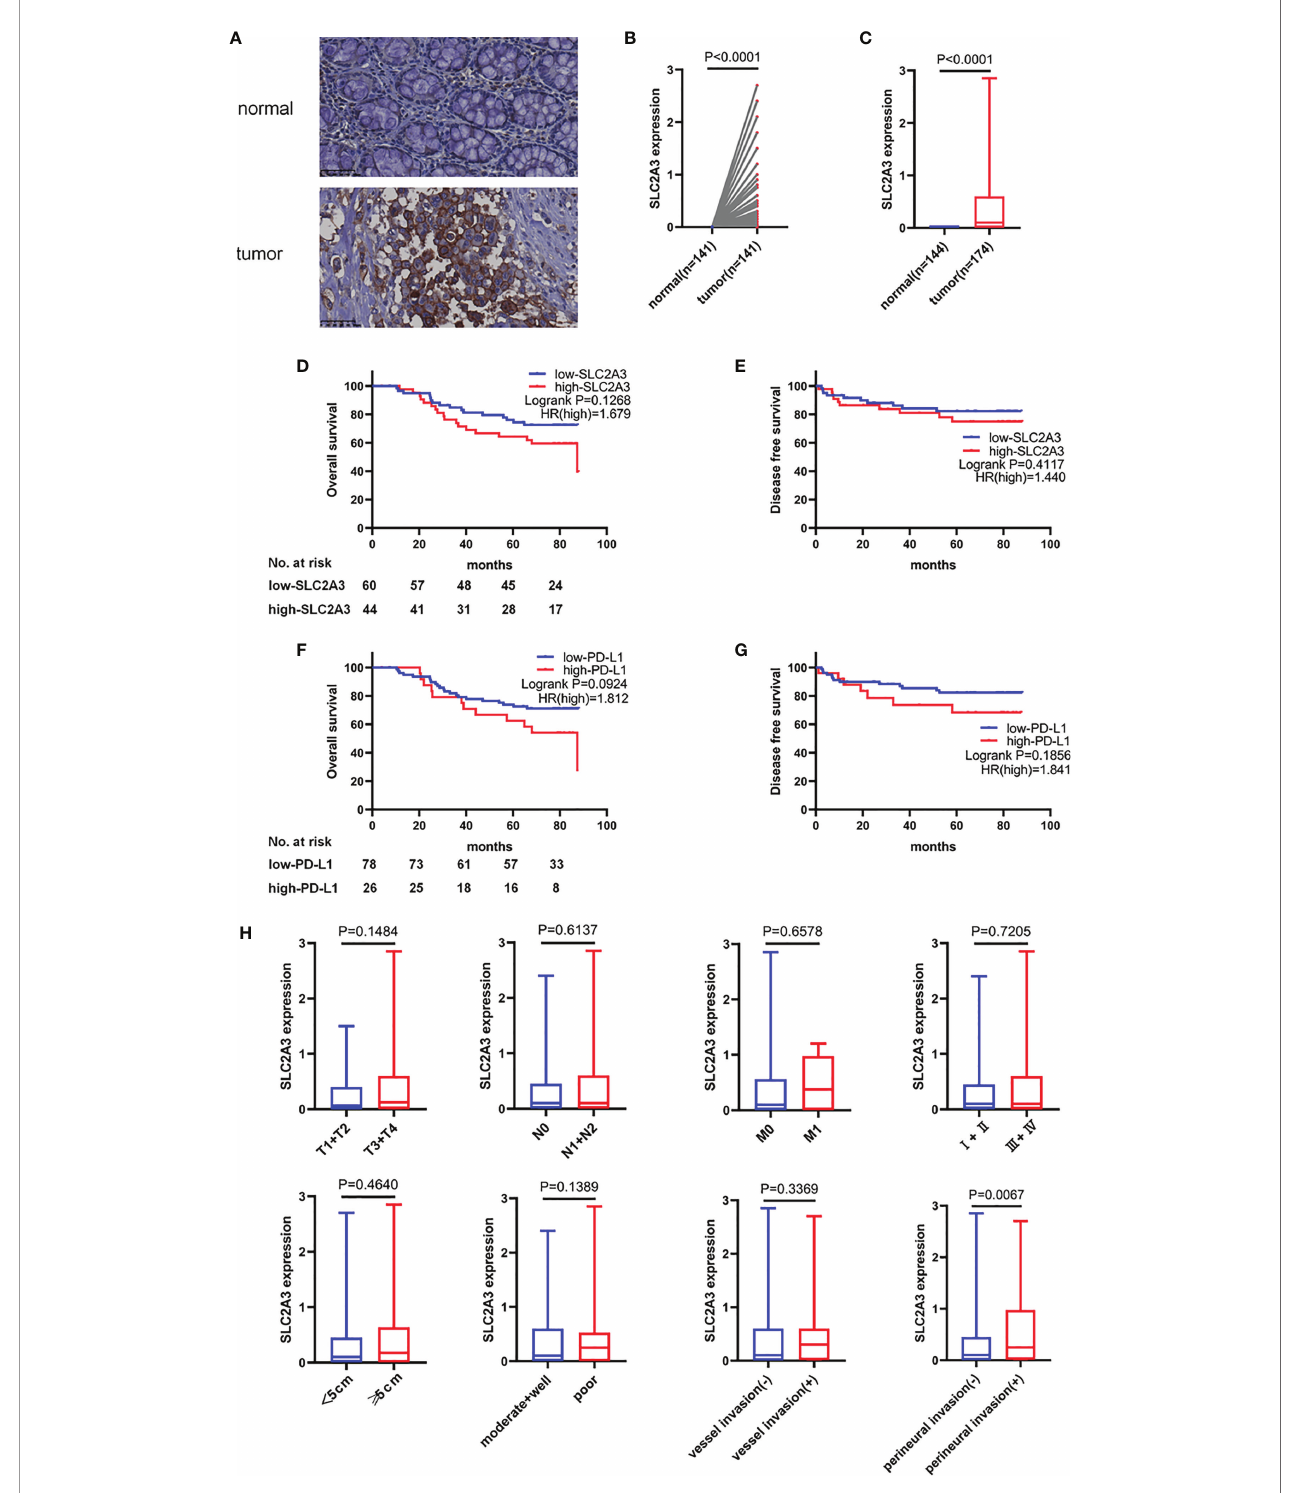
FIGURE 7 | SLC2A3 and PD-L1 expression in CRC tissues. (A) SLC2A3 expression in CRC and adjacent non-tumor colorectal mucosal tissue by immunohistochemistry staining. Expression of SLC2A3 in (B) paired and (C) unpaired CRC tissues and non-tumor colorectal mucosal tissues, respectively; prognostic role of (D, E) SLC2A3 and (F, G) PD-L1 expression in CRC samples; (H) the relationship between SLC2A3 expression and T, N, M, clinical stage, tumor size, degree of differentiation, vessel invasion, and perineural